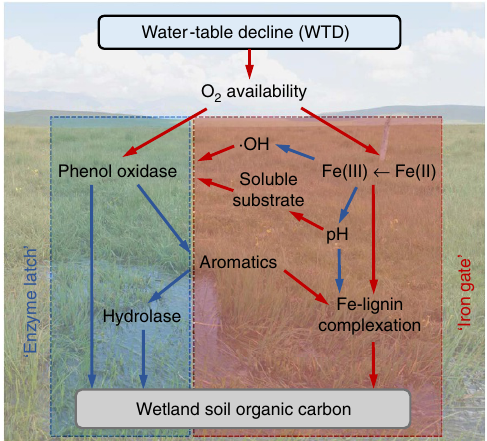
Figure 5 | Proposed conceptual model showing the iron gate versus enzyme latch mechanisms during water-table decline. Red and blue arrows indicate positive and negative influences, respectively. O 2 -induced oxidation of ferrous iron [Fe(II)] to ferric iron [Fe(III)] decreases phenol oxidative activity through decreasing hydroxyl radicals ( (cid:4) OH) and reducing soluble substrates via pH decline. Reduced phenol oxidative activity leads to increased aromatic structures, which further enhances Fe-lignin complexation together with the pH decline. The ‘iron gate’ mechanism may hence lead to soil carbon stabilization under wetland water-table